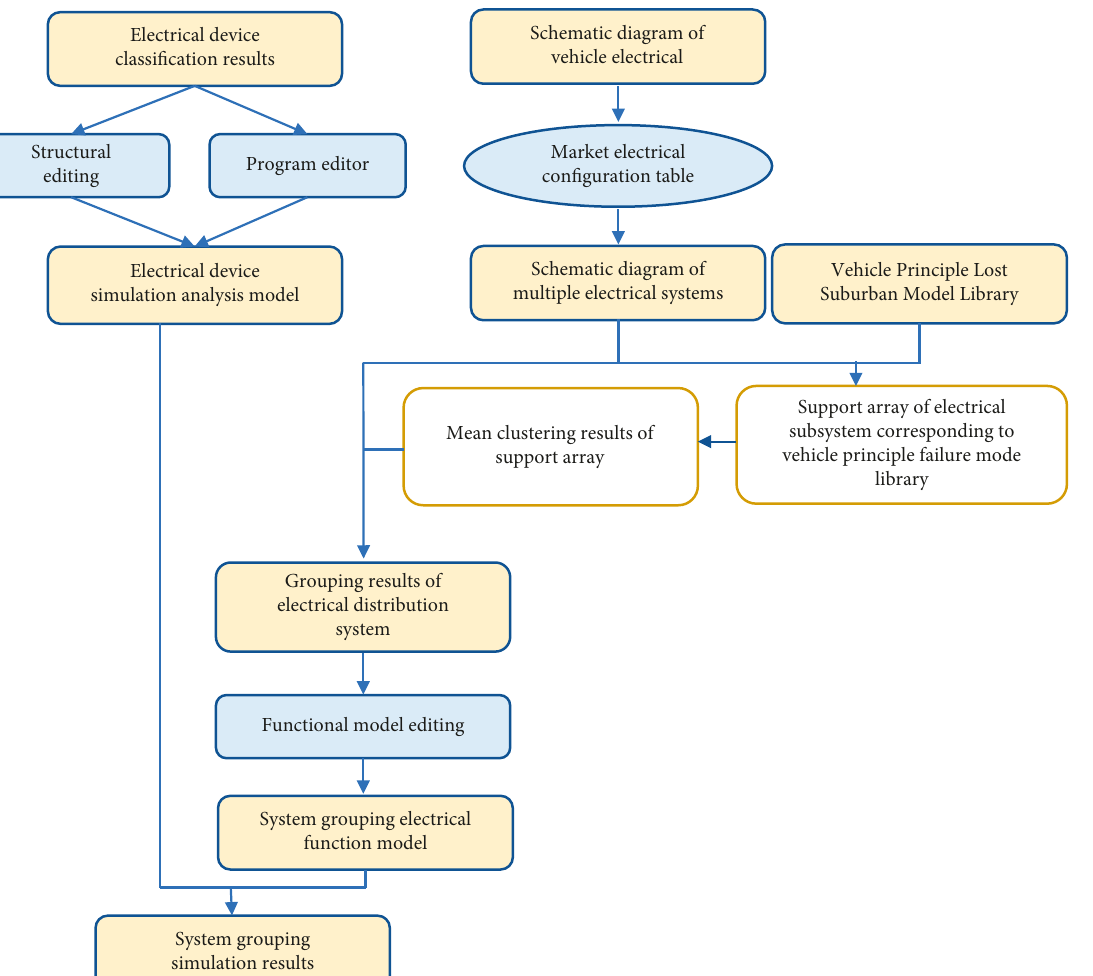
Figure 2: 3D simulation analysis and flow of fast wire harness